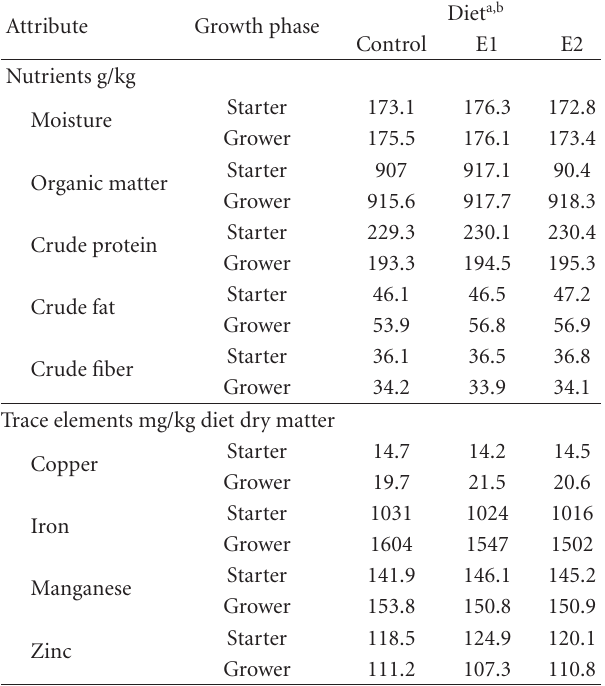
Table 2: Chemical composition of the experimental diets (analyzed